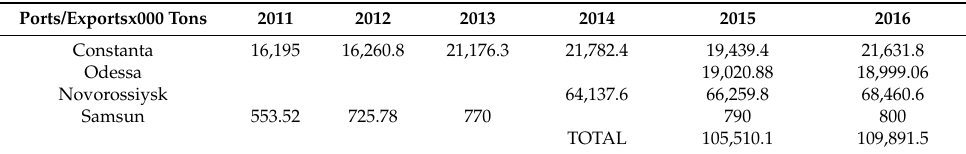
Table 3. Annual report of the tonnage exports from Black Sea’s